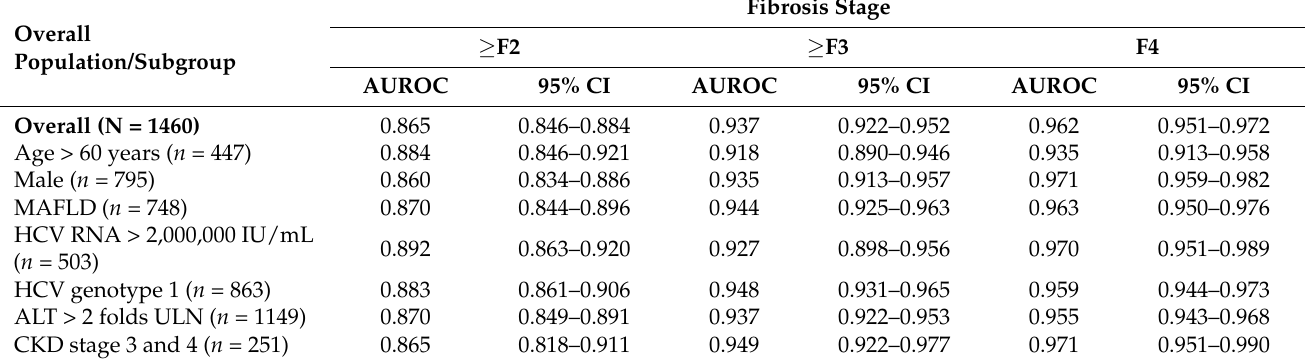
Table 2. The areas under the receiver operating characteristic (AUROCs) of M2BPGi in predicting the severity of hepatic fibrosis.